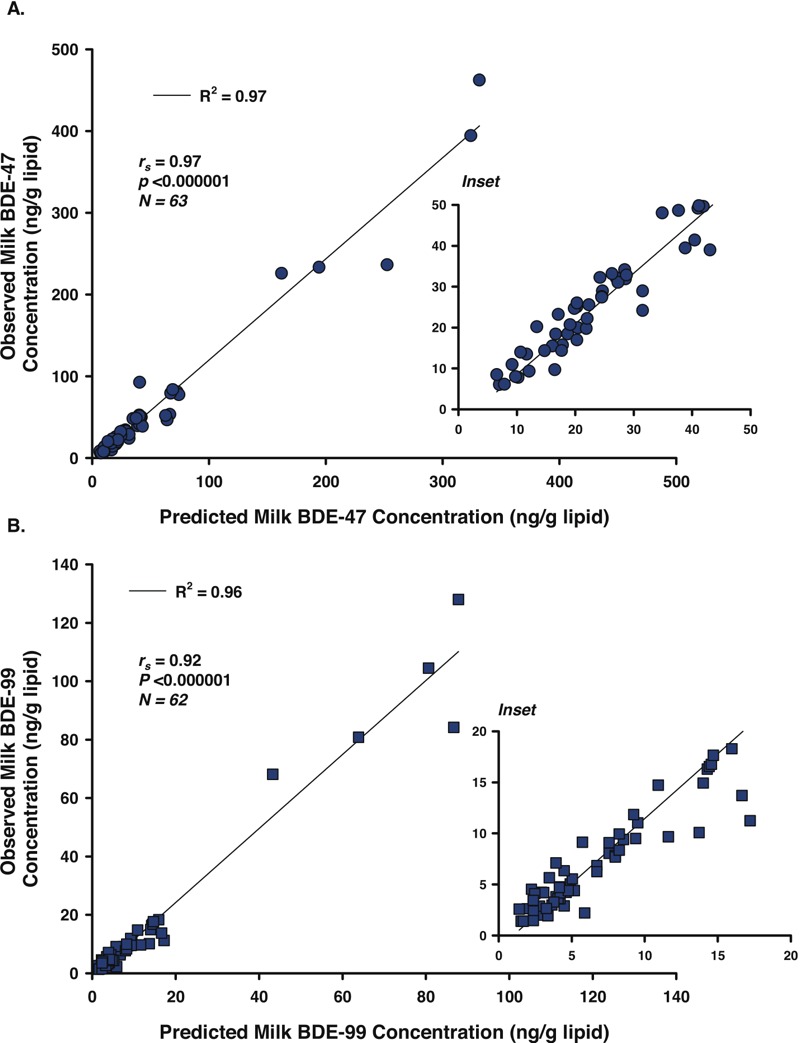
Predicted milk BDE-47 (A) and BDE-99 (B) concentrations versus those observed in MAMA Study participants. Solid lines are the least-squares fit of predicted and observed concentrations [R
2 = 0.97, slope = 1.24 (A); R
2 = 0.96, slope = 1.27 (B)]. Spearman correlation coefficients (r
s) and related p-values are shown.